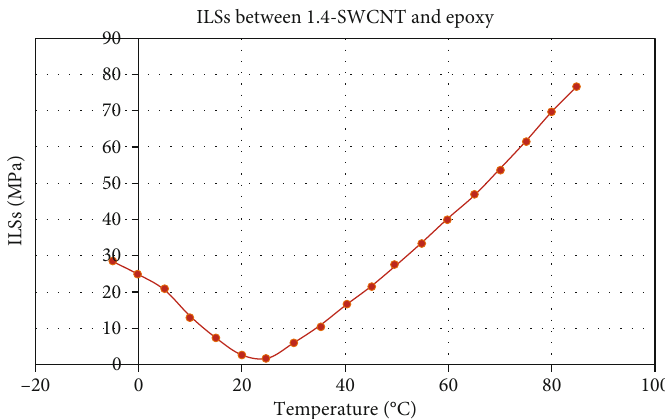
Figure 6: ILSs within the interface of 1.4-SWCNT and epoxy at the temperature range of -5 to 85 ° C within the 1.4-SWCNTE.